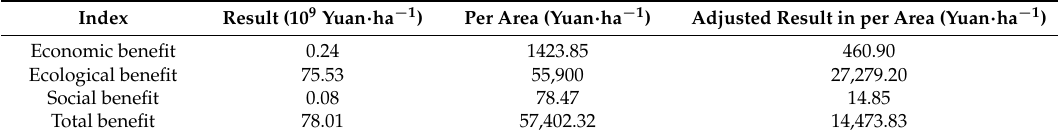
Table 9. Total benefit of forest in Yanqing District in